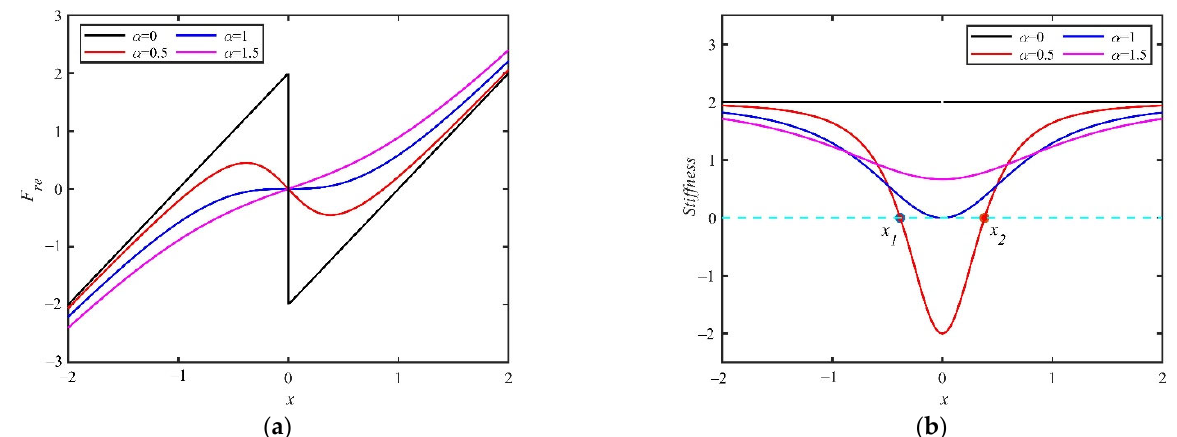
( b ) F ; ( b ) the stiffness of the SD oscillator; two points are Figure 2. ( a ) The nonlinear restoring force Figure 2. ( a ) The nonlinear restoring force F re ; ( b ) the stiffness of the SD oscillator; two points are re √ √ 2/3 1 x       and 2/3 1 x      , respectively. x 1 = − α α − 2/3 − 1 and x 2 = α α − 2/3 − 1, 1 2